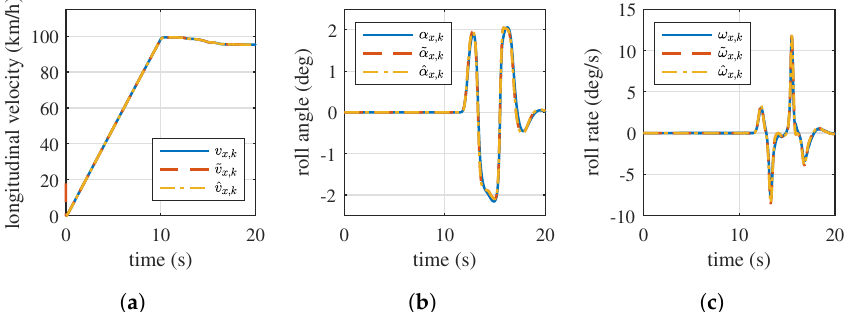
Figure 10. Observer (5) and neural identifier (24) performances in terms of longitudinal velocity v x , k , roll angle α x , k and roll rate ω x , k . ( a ) Vehicle longitudinal velocity. ( b ) Vehicle roll angle. ( c ) Vehicle roll rate.